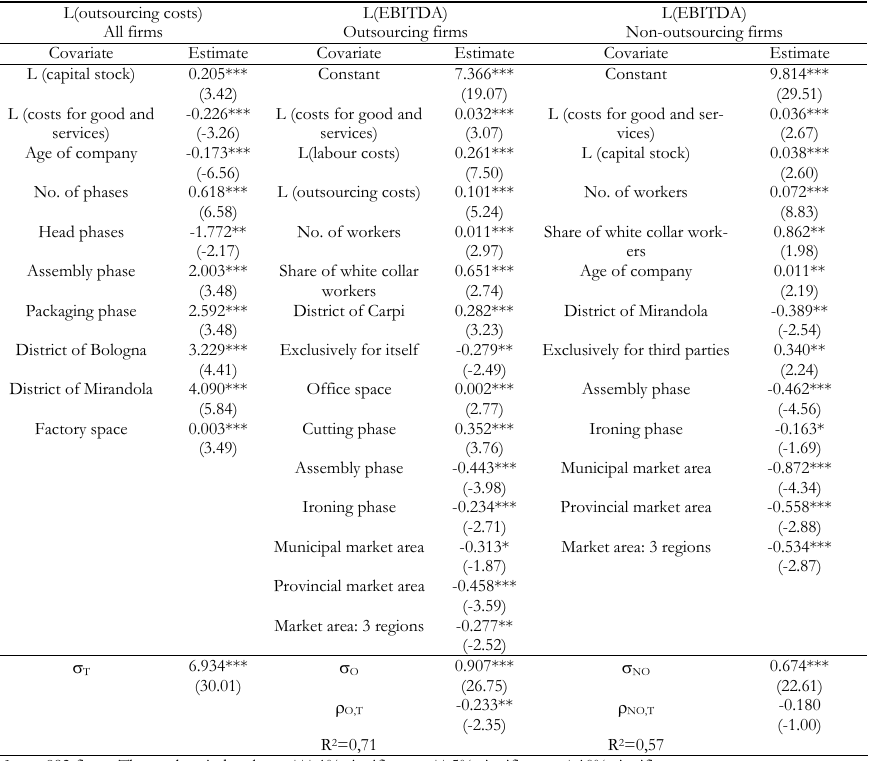
Results for firms with employees: effects on